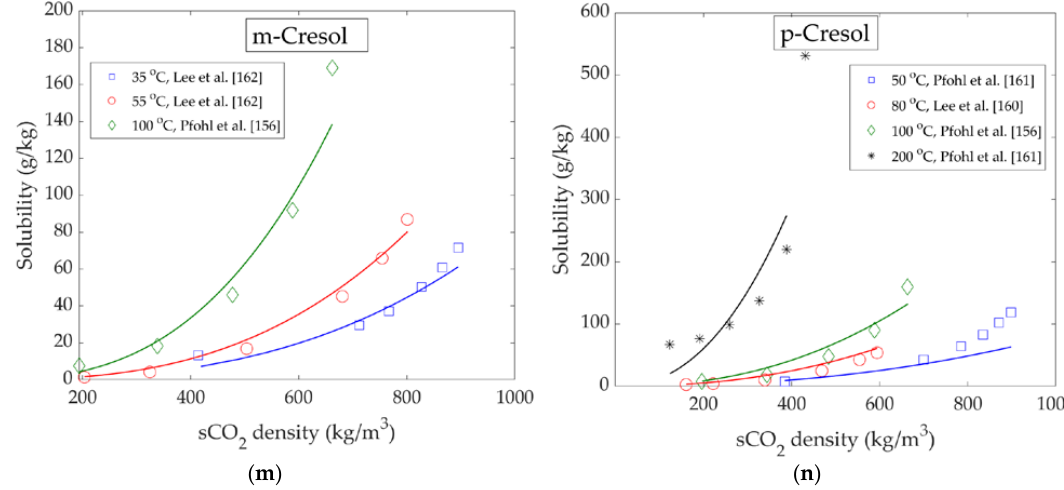
Figure 9. Solubility isotherms vs. sCO 2 density for all components studied. Markers indicate experimental data, while continuous lines are obtained with the Chrastil model. ( a ) Heptanoic acid; ( b ) Hexadecanoic acid; ( c ) Cumene; ( d ) Phenol; ( e ) Cyclohexanone; ( f ) Naphthalene; ( g ) Hydroxymethylfurfural; ( h ) Benzeneacetic and benzoic acid; ( i ) Catechol; ( j ) Vanillin; ( k ) Guaiacol; ( l ) o-Cresol; ( m ) m-Cresol; ( n ) p-Cresol.